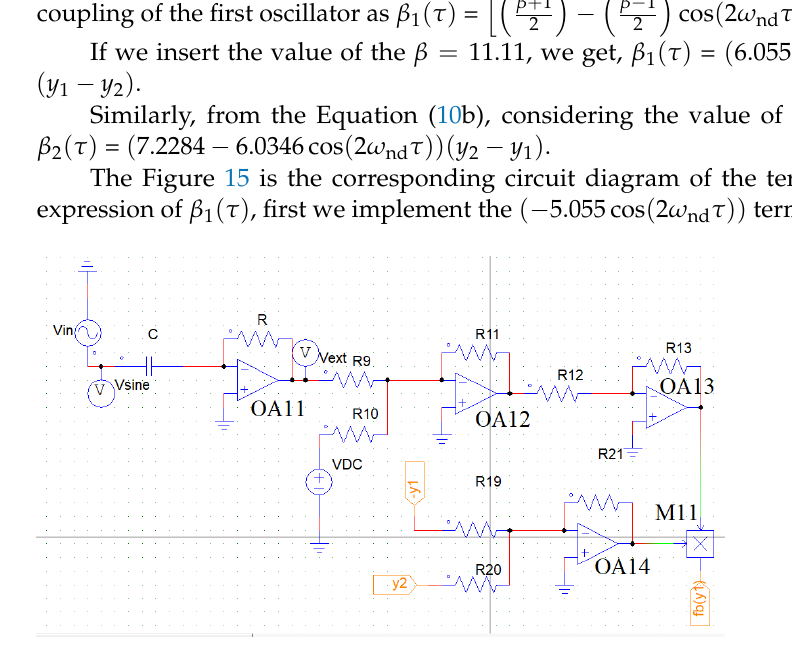
Figure 15. The equivalent circuit diagram of the non-dimensional spring force term β 1 ( τ ) . The resistance values are: R = R 9 = R 10 = R 11 = R 13 = R 12 = R 19 = R 20 R 21 = 100 k Ω . The capacitor C = 1 nF. OA11, OA12, OA13, and OA14 are the four Op-Amps, M 1 1 is the multiplier. V in is the sine wave originating from a function generator. V DC is a dc voltage source of value 6.055 V. (Color